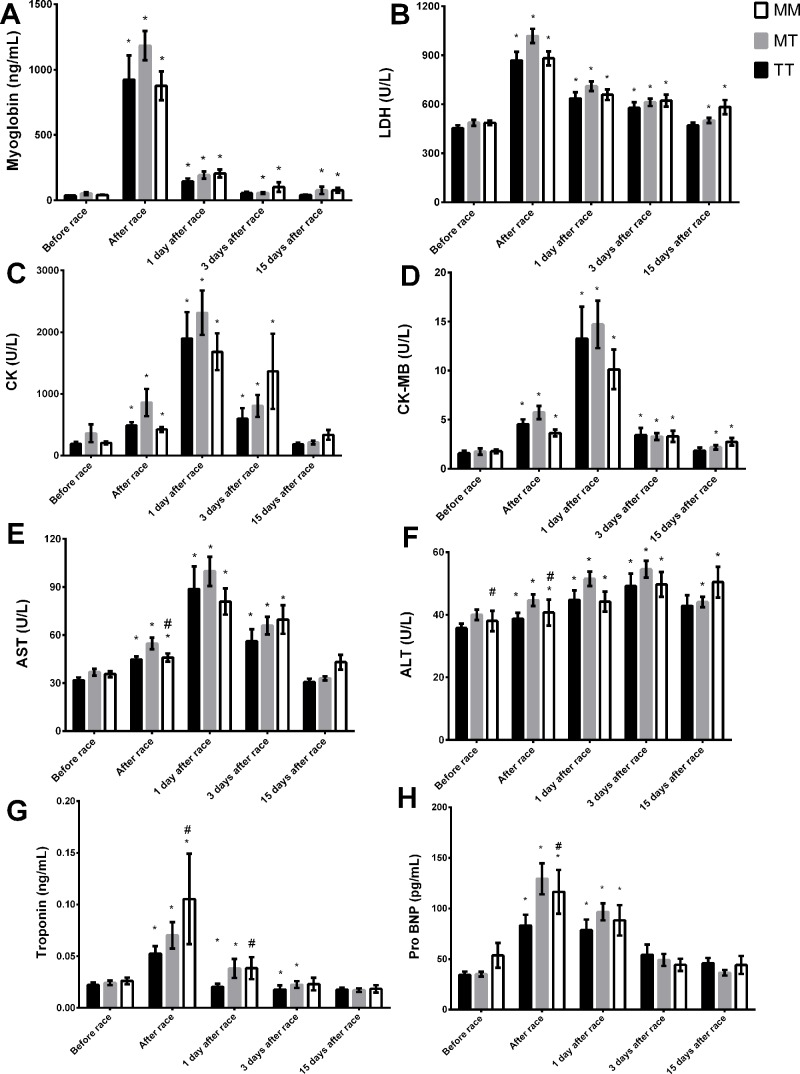
Effect of marathon on markers of muscle damage in MM, MT and TT AGT genotypes. The markers of muscle damage evaluated were myoglobin (A); lactate dehydrogenase, LDH, (B); creatine kinase, CK (C); CK-MB (D); aspartate transaminase, AST (E); alanine transaminase, ALT (F); troponin (G); brain natriuretic peptide, Pro BNP (H). The values are presented as of mean ± SEM of 16–43 runners. *P < 0.05 vs before; #P < 0.05 MM vs TT genotype.